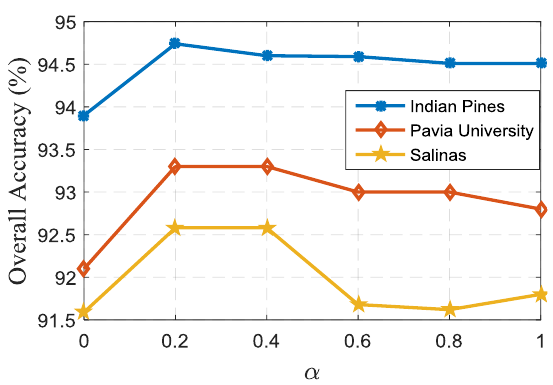
Figure 6. The effect of controlling parameter α on classification results for three data sets.